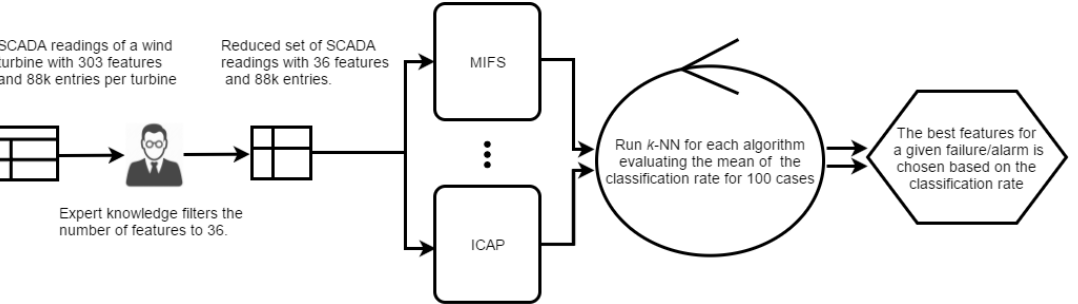
Figure 3. General scheme of the